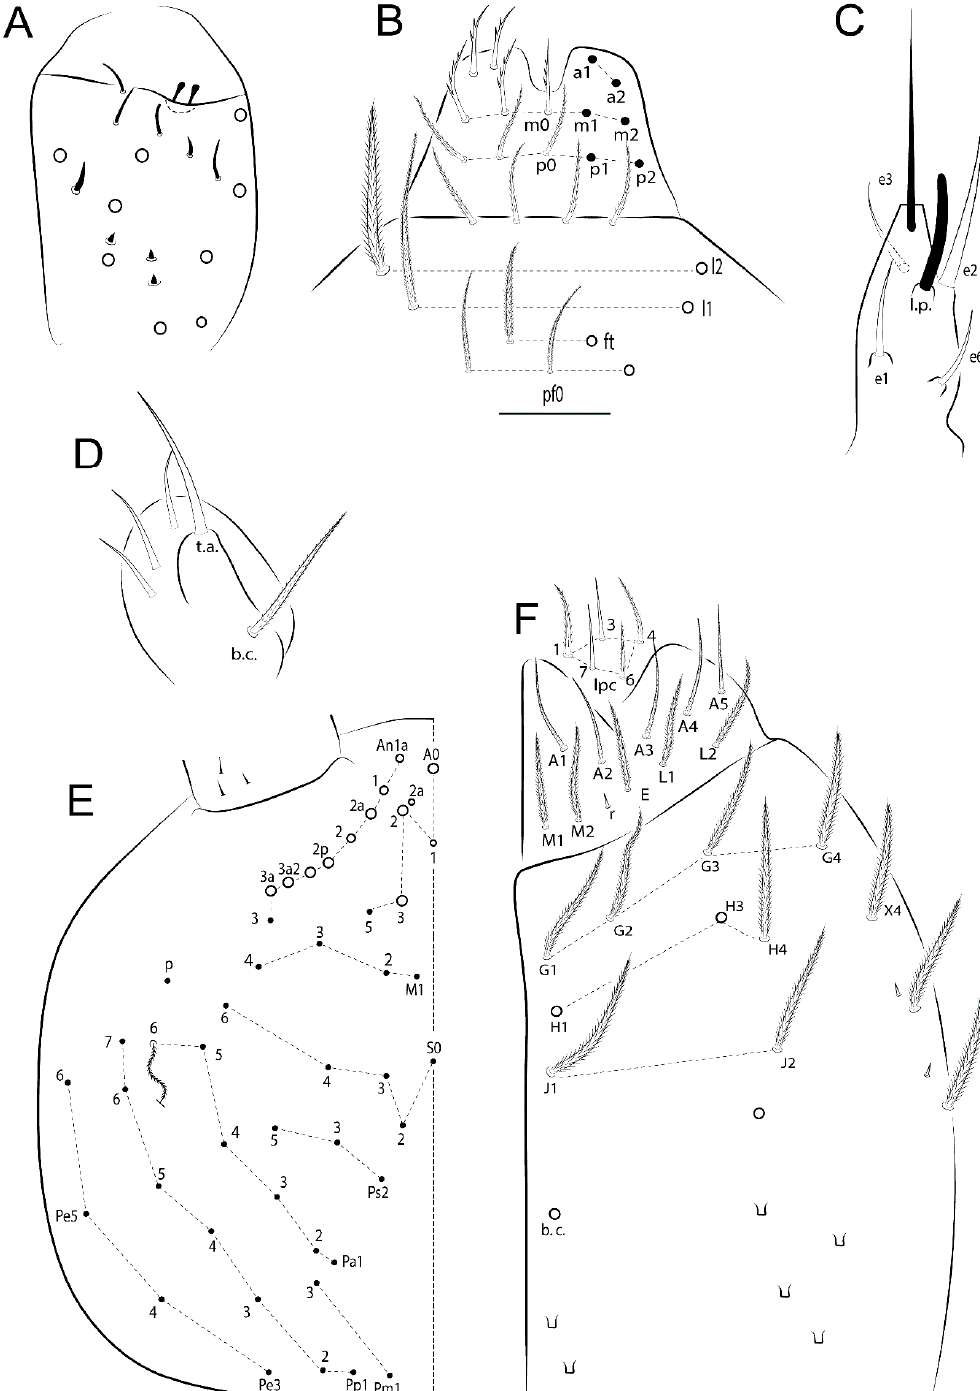
Figure 43. Pseudosinella cearensis sp. nov.: head. ( A ) Ant III apical organ (lateral view); ( B ) chaetotaxy of clypeus, prelabrum, and labrum; ( C ) labial papilla E; ( D ) maxillary palp and sublobal plate (right side), minute appendage omitted; ( E ) head dorsal chaetotaxy (left side); ( F ) labial proximal chaetae, basomedian and basolateral labial fields, and complete postlabial chaetotaxy (right side).